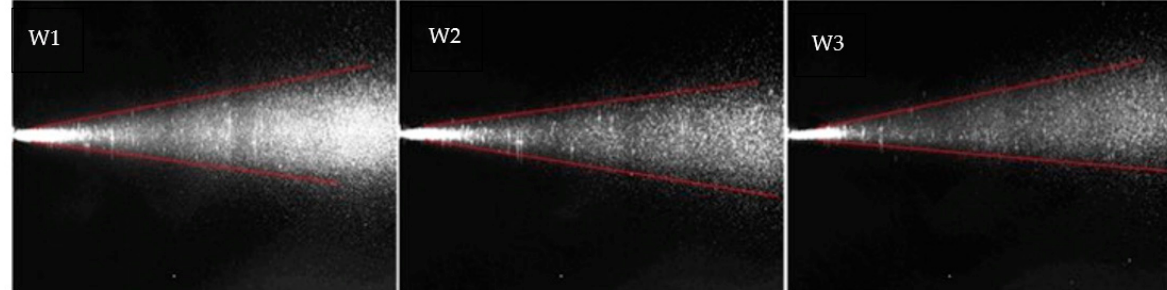
Figure 4. Representative images of instant visualization of the subsequent three water sprays.